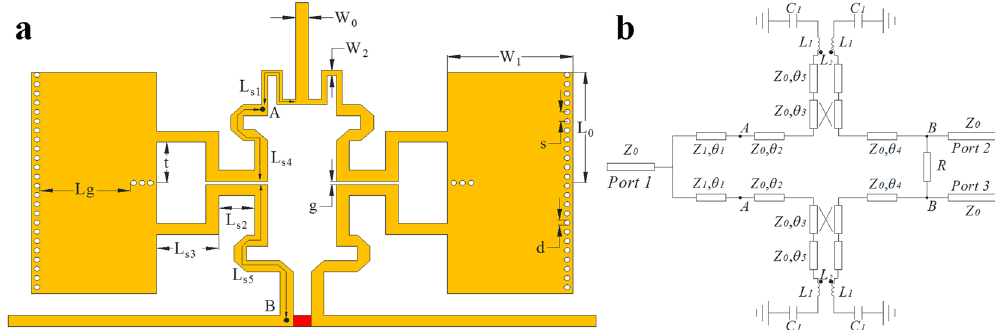
Figure 3. Presented single-band filtering QMSIW power divider ( a ) Configuration ( b ) Equivalent circuit.